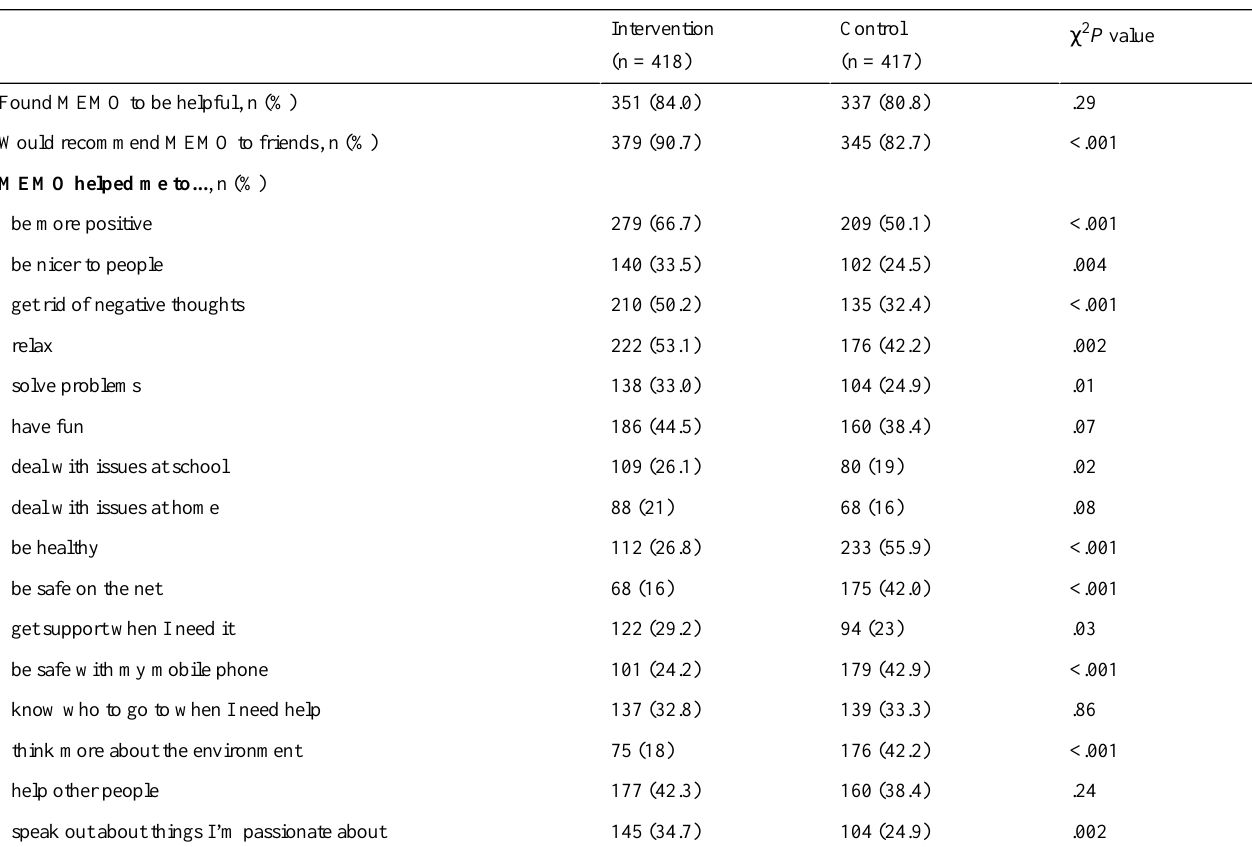
Table 3. Participant satisfaction and perceived usefulness of